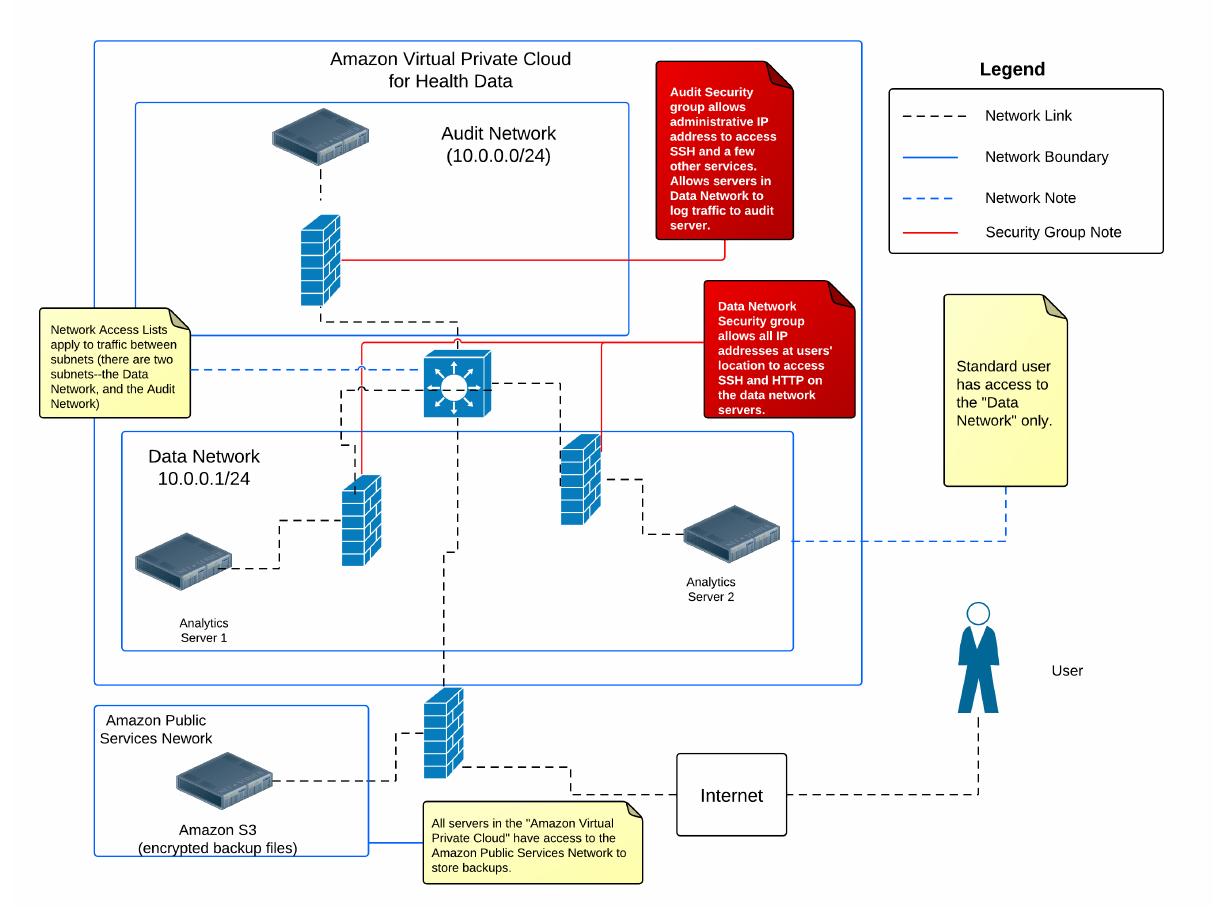
Figure 1. Our prototype environment for HIPAA data, utilizing two subnets, the “Data Network” for servers, and the “Audit Network” for an audit and monitoring